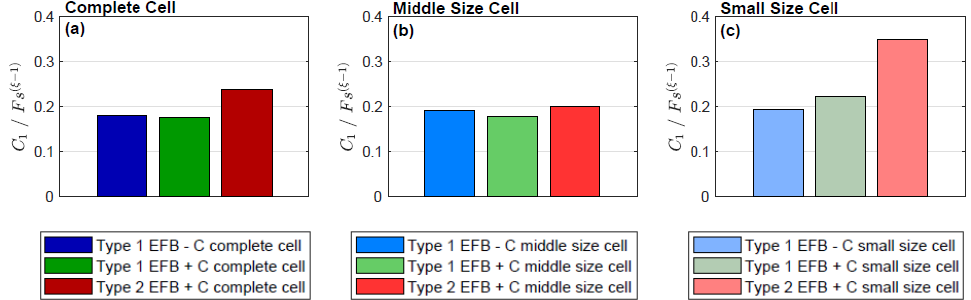
Figure 10. Fitting result C 1 of the laboratory test cells for ( a ) complete cell: 8P8N/8P9N, ( b ) middle size cell: 3P2N and ( c ) small size cell: 2P1N.